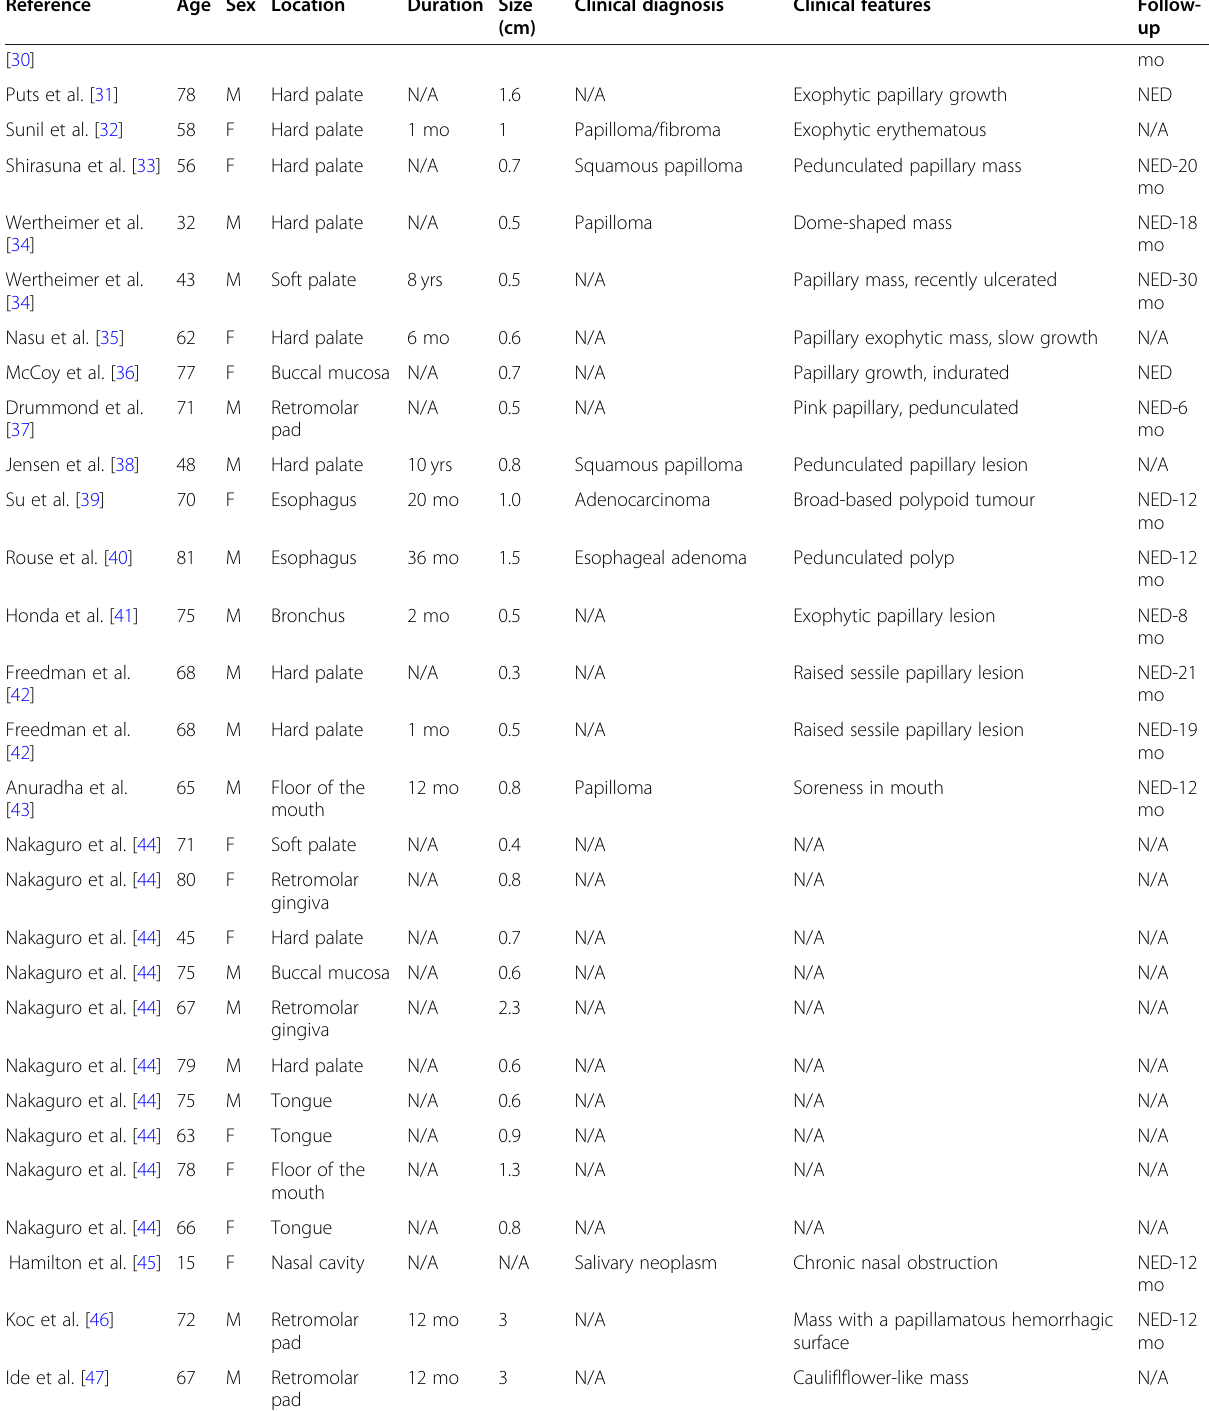
Table 1 Clinical features of sialadenoma papilliferum (95 cases, but 94 cases available) (Continued)